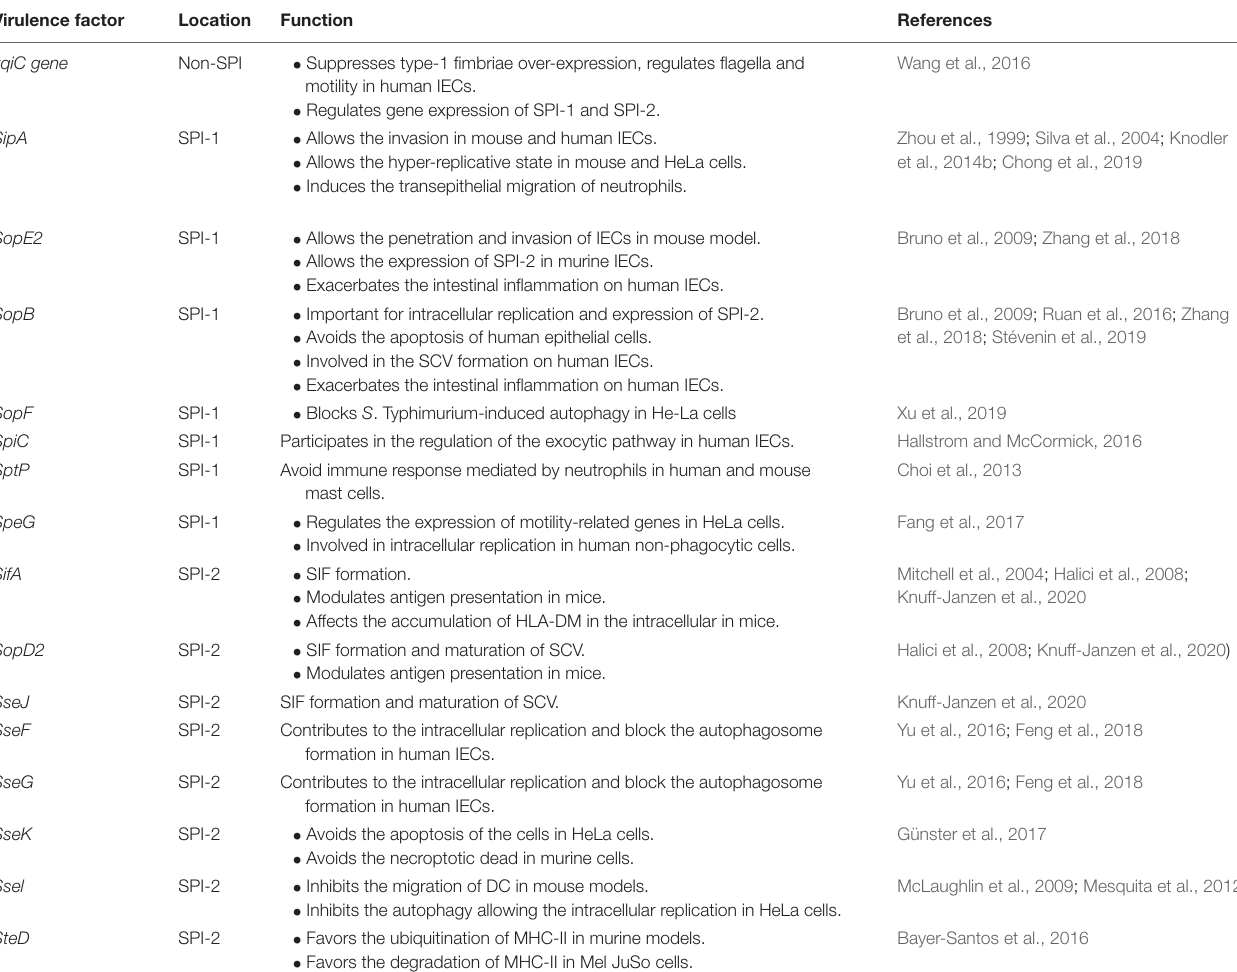
TABLE 1 | Virulence factor of S. Typhimurium, their location and main function in human and murine